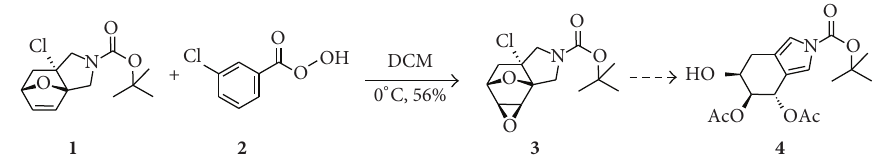
S 1: Synthesis of the tert -butyl 3a-chloroperhydro-2,6a-epoxyoxireno[ e ]isoindole-5-carboxylate.